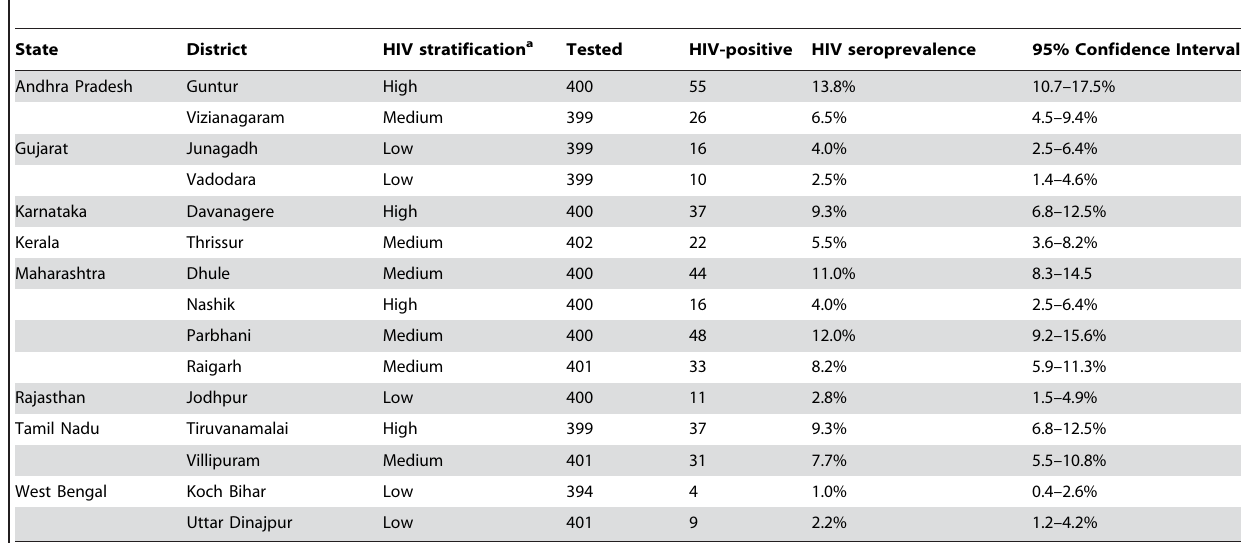
Table 1. HIV seroprevalence among tuberculosis patients in 15 districts in India,